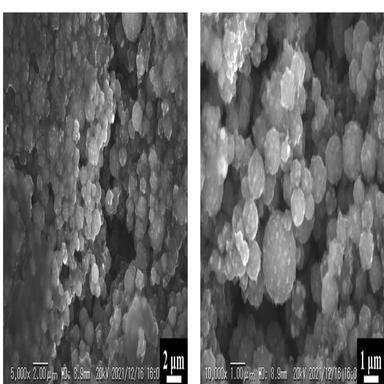
SEM images of the porous-crystalline C/Fe3O4 microspheres observed at different magnifications after 200 charge/discharge cycles at 1000 mA g1 .